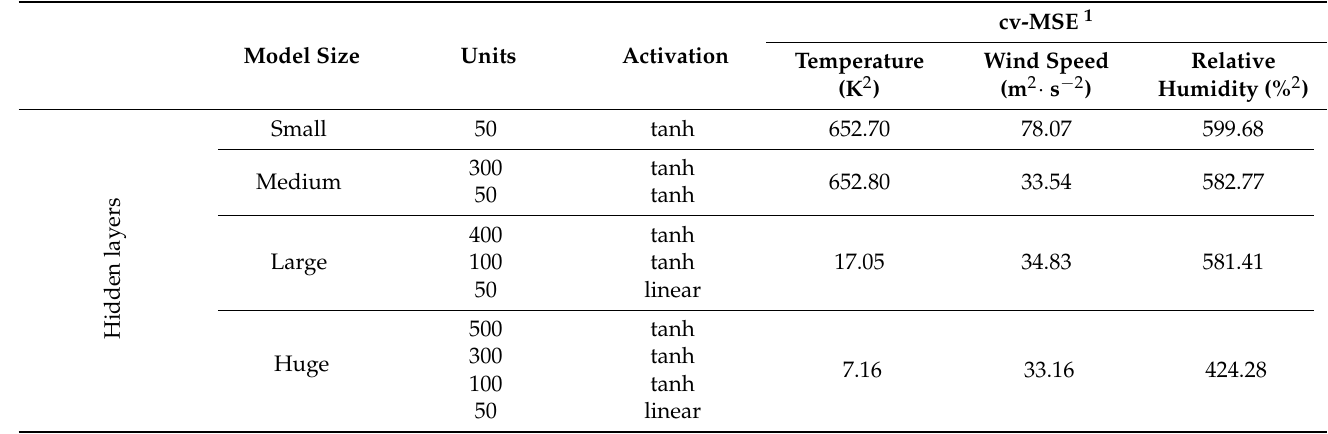
Table 1. cv-MSE on the test set with four network models of different sizes.